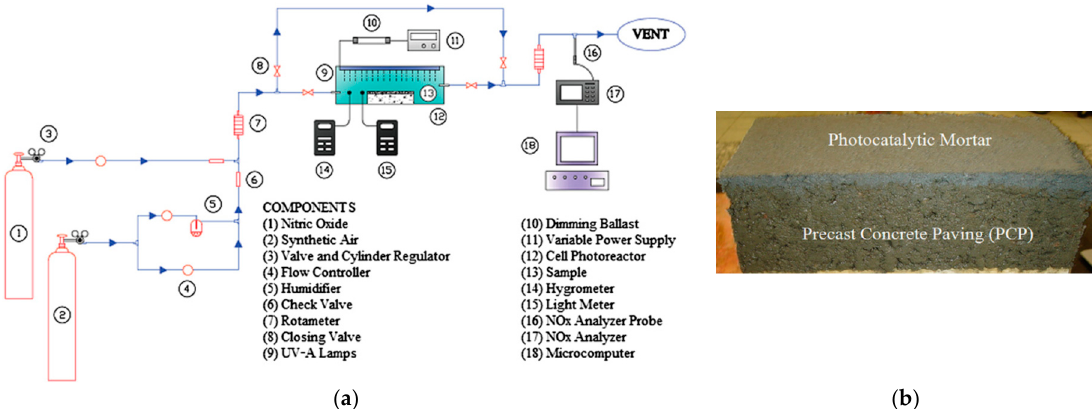
Figure 35. ( a ) Photoreactor in a flow-through assembly for the measurement of photocatalytic activity of a photocatalytic mortar for the abatement of NO x ; and ( b ) photocatalytic mortar applied to a Precast Concrete Paving sample. Reproduced with permission from Staub de Melo and Triches